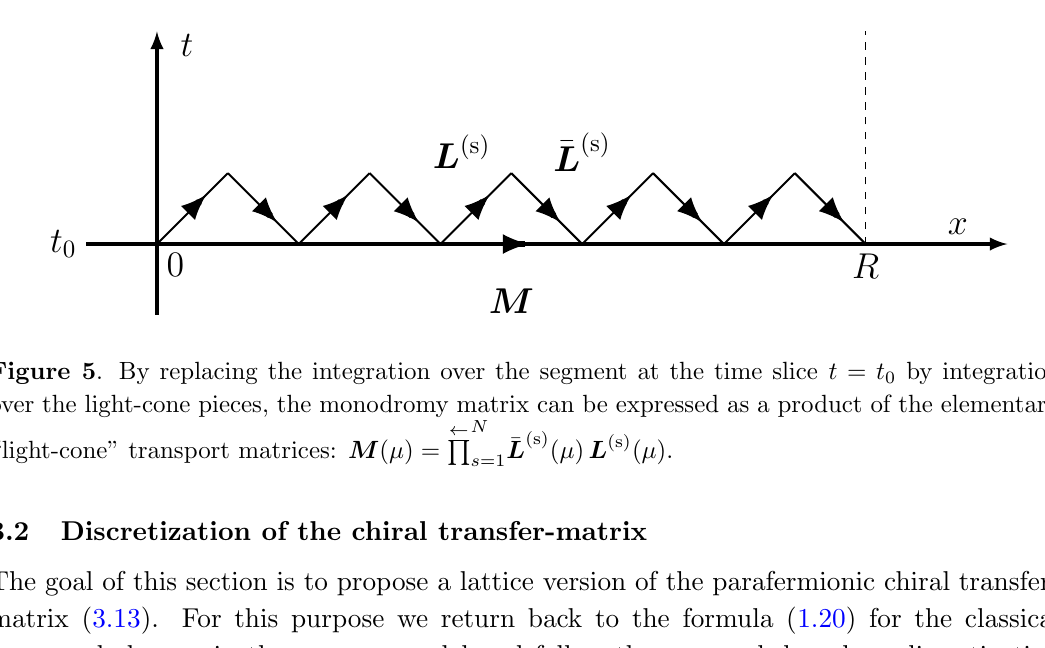
N (cid:22) L (s) ( (cid:22) ) L (s) ( (cid:22) s =1